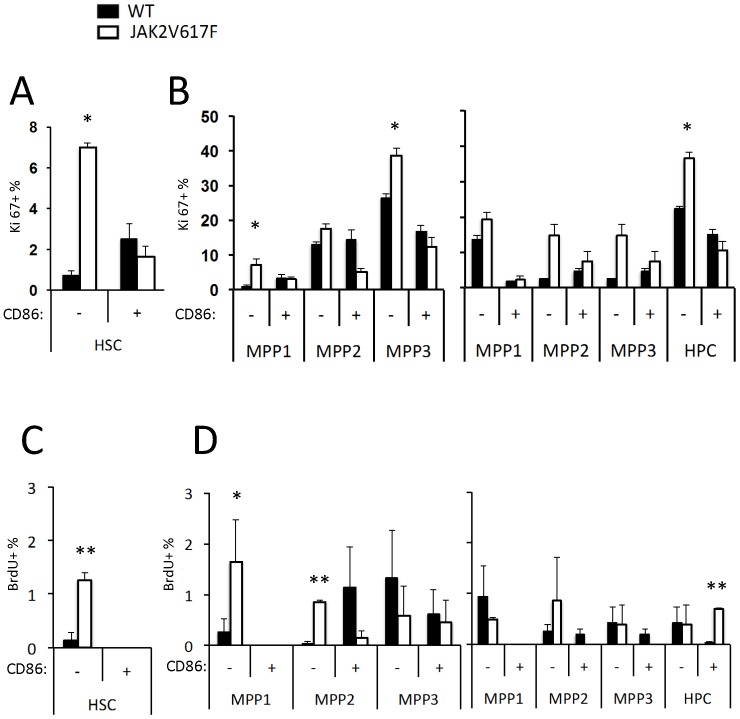
The JAK2V617F transgene may slightly alter proliferation of stem/progenitor cells.The CD150+ CD48− HSC (A) and the multipotent progenitors (B) described Fig. 4 were stained with the proliferation associated Ki67 marker. Percentages of Ki67+ cells in BM were calculated. As another approach, the same marrow samples were pulsed with BrdU in very short-term cultures before staining (C, D). These results are given as percentages of BrdU+ cells per subset and significance is indicated by asterisks p<0.01(**), p<0.05(*). These data were obtained in a single experiment (N = 3).